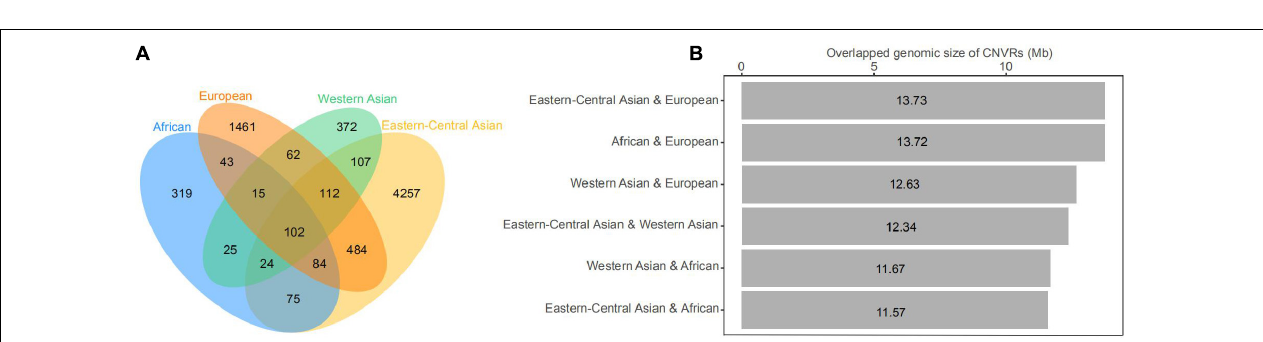
FIGURE 3 | Validation of copy number variations (CNVs) (i.e., five duplications and eight deletions) by quantitative PCR (qPCR). The x- and y -axes represent sample ID and relative CNVs expression level [2 × 2 − ((cid:49)(cid:49) CT ± SD ) , n = 3].